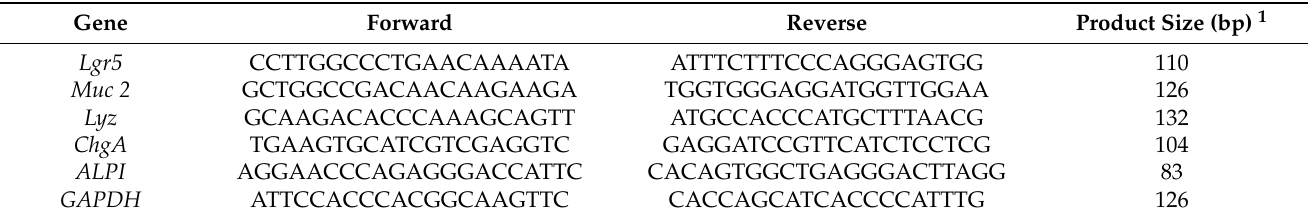
Table 1. List of primers used for this